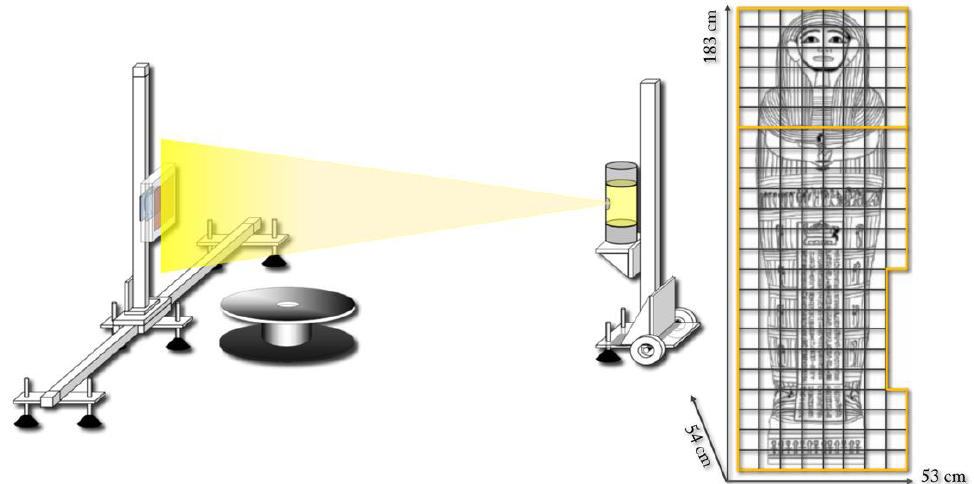
Figure 3. Tomographic acquisition set-up: on the left, the layout of the CT facility; on the right, the tile-scanning grid used to collect the entire tomographic data sets.